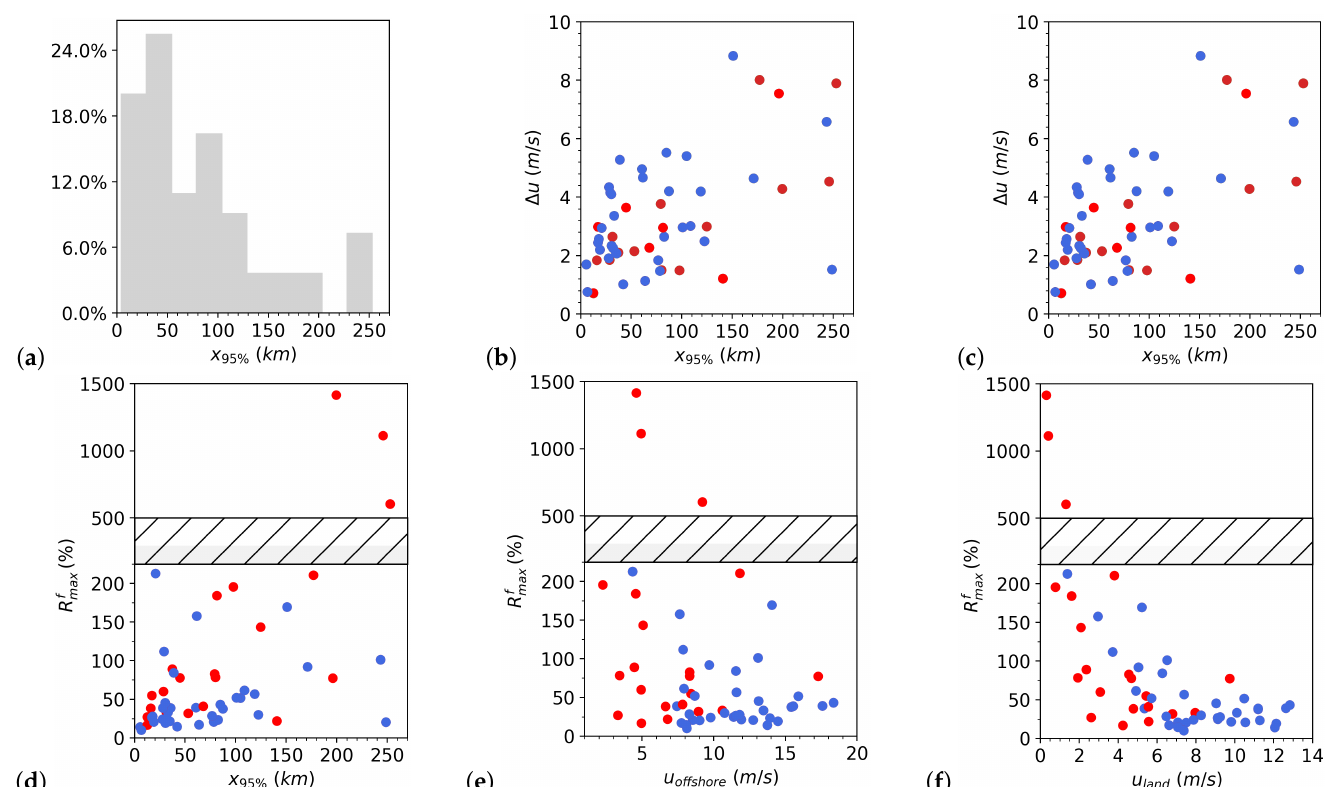
Figure 12. Statistical distribution of estimated parameters x 95% , ∆ u , R f max , u land , u of fshore with respect to thermal stratification from combined wind directions. Histogram of the adjustment distance x 95% ( a ). Scatter plots of wind increase ∆ u versus x 95% ( b ) and versus u of fshore ( c ). Scatter plots of maximum normalised wind increase R f max versus x 95% ( d ), versus u of fshore ( e ), and versus u land ( f ). The hatched areas separate the top and low frames, which have different scaling in the vertical axis. Blue and red colors refer to unstable and stable cases,